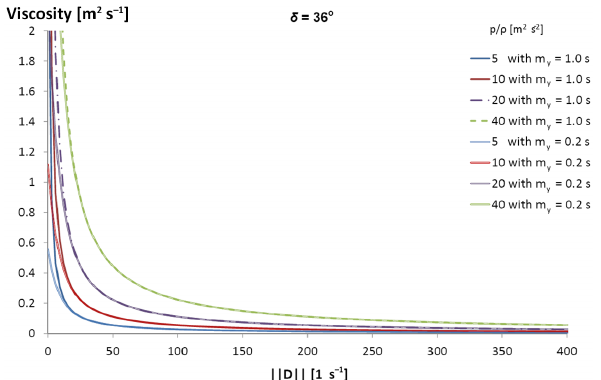
Figure 3. Dependency of the kinematic gravel phase viscosity ν s (normalized by density) on the norm of the strain rate tensor || D || at different levels of pressure normalized by density for m y = 1s, m y = 0 . 2s, and a friction angle δ = 36 ◦ .